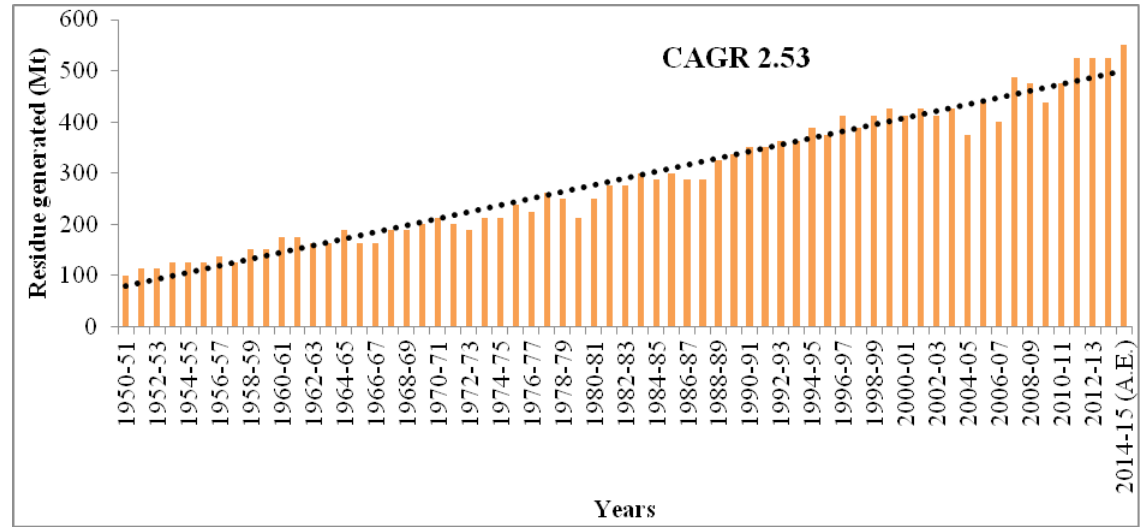
Fig. 1: The trend of crop residue generation in India. (Source: Compiled by author from data provided by Ministry of Statistics and Program Implementation (MOSPI, 2013-14))